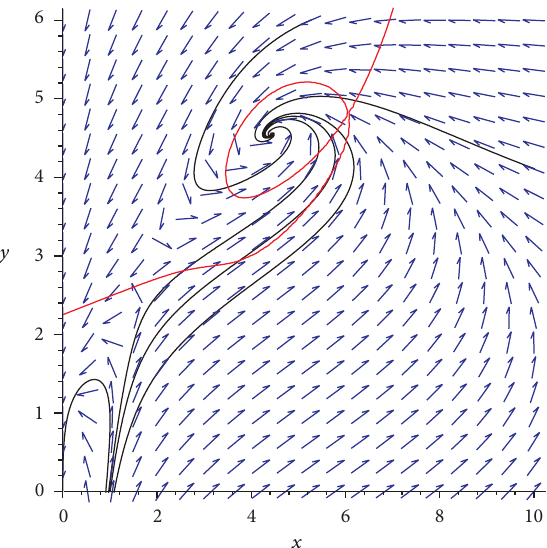
Figure 1: The DOA when (𝐴,𝛽, 𝑣,𝑐, 𝑎, 𝜇,𝑘) = (19.2, 0.5, 1,10, 0.5, 1, 0.25) for the model (17).